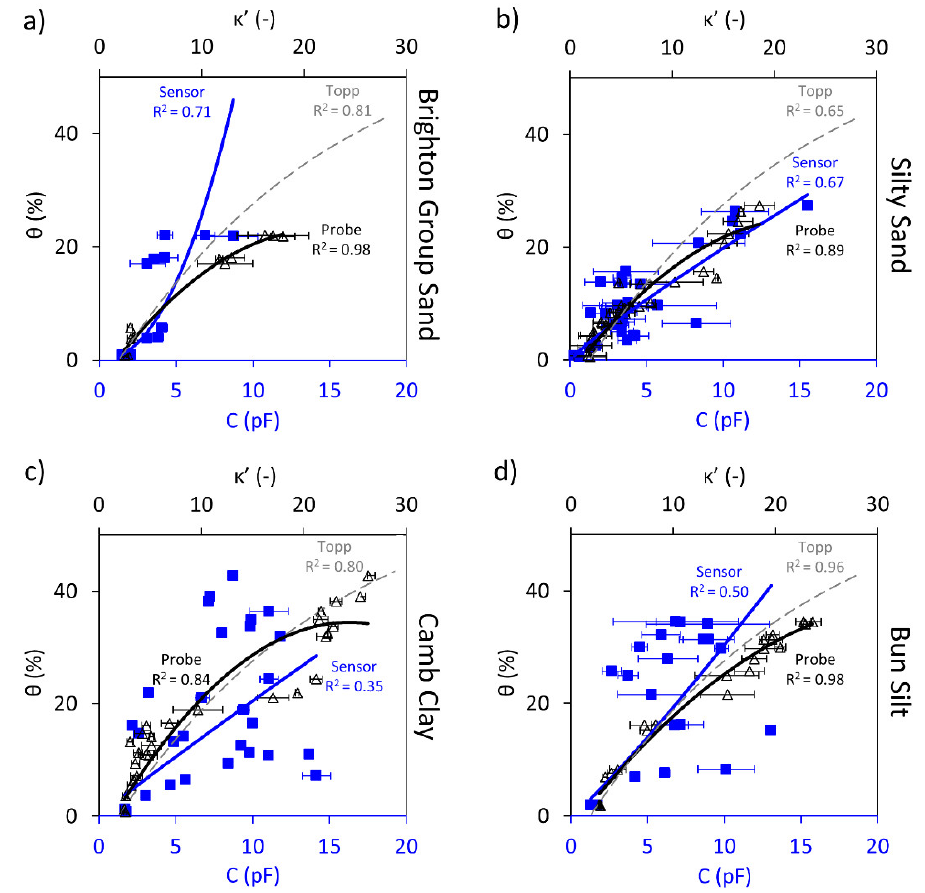
Figure 3. Circular sensor capacitance, C, readings (blue square markers and trendline) and dielectric constant, κ’, measurements (black triangular markers and trendline) shown against the volumetric water content, θ; the Topp equation is also shown (dashed grey trendline). Shown for: ( a ) Brighton Group Sand ( b ) Silty Sand ( c ) Camb Clay and ( d ) Bun Silt.